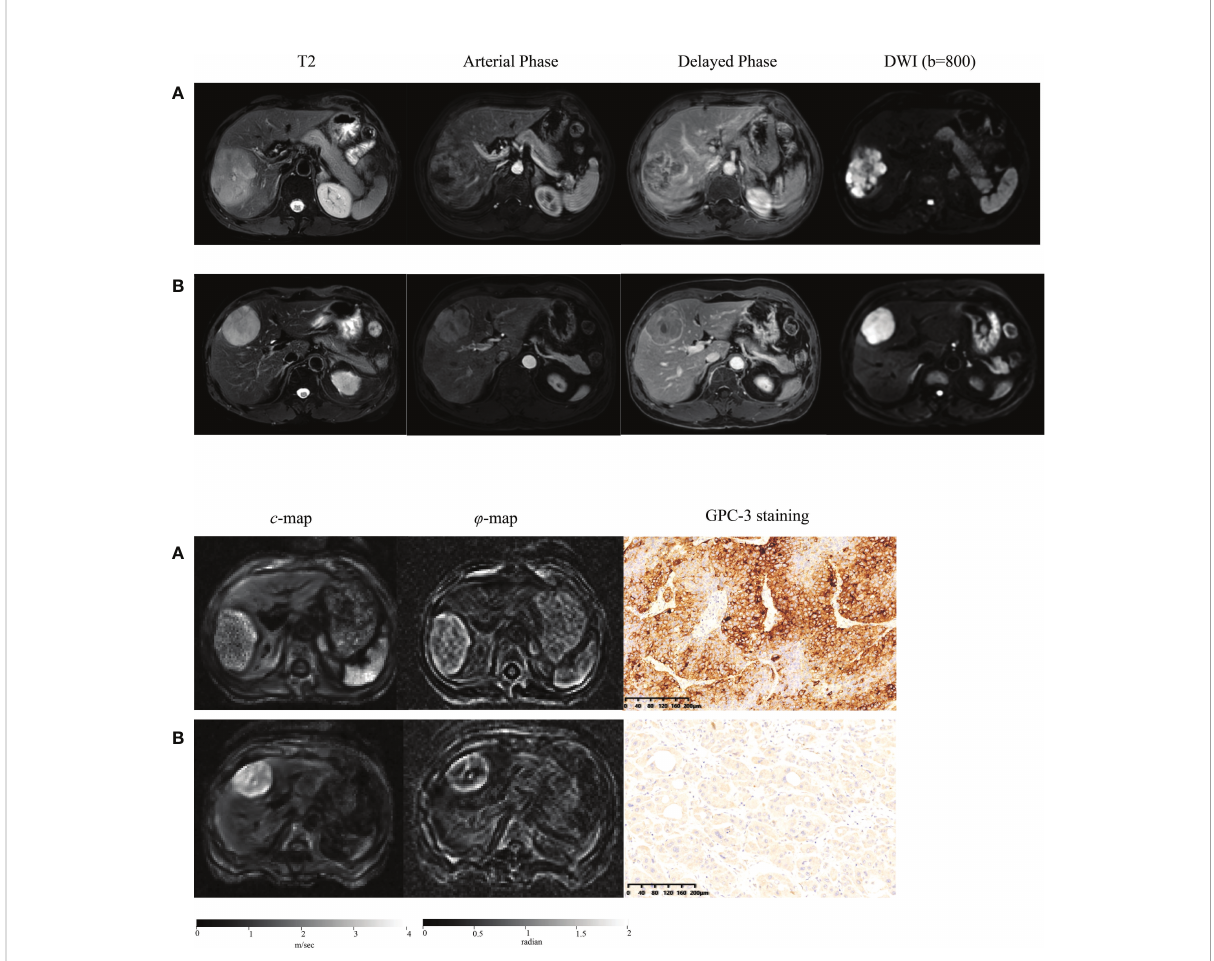
FIGURE 2 Representative axial T2-weighted images; arterial phase images; delayed phase images; axial diffusion-weighted images (DWI) at b -value of 800 sec/mm 2 ; axial tomoelastography c and j maps, and immunochemistry-stained section images of tumors (magni fi cation, ×20) obtained in a patient with GPC3-positive HCC (A) and in a patient with GPC3-negative HCC (B)